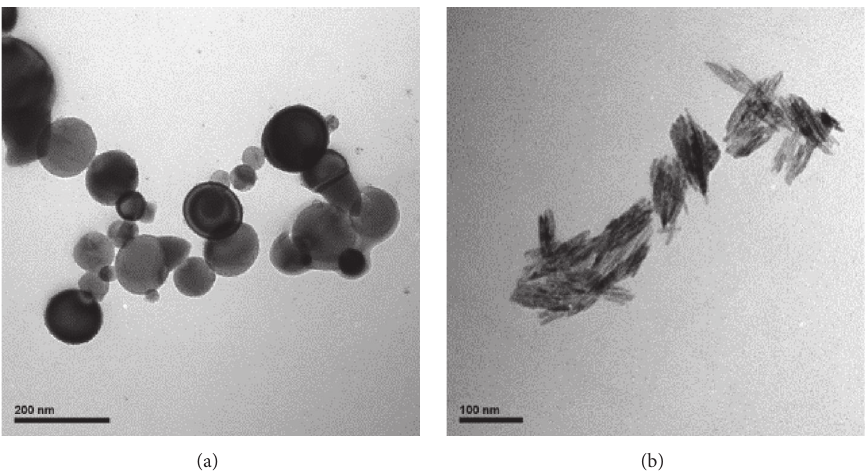
Figure 1: TEM image of the (a) Si NPs and (b) Fe 2 O 3 NPs used in this study.